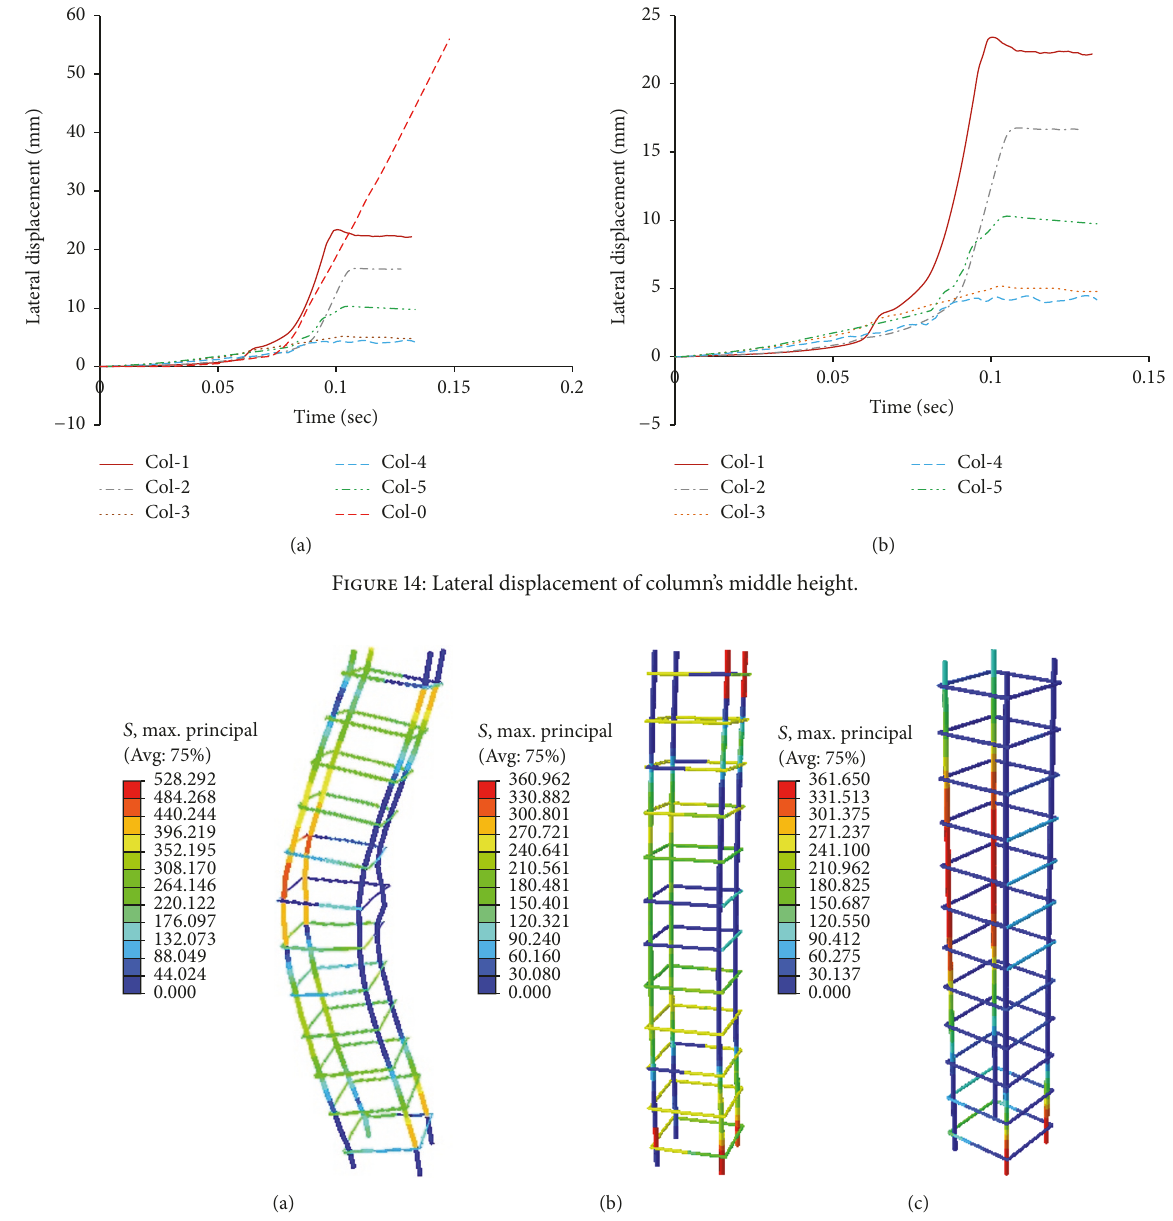
Figure 15: Deformations of steel bars in (a) Col-0, (b) Col-3, and (c) Col-5.